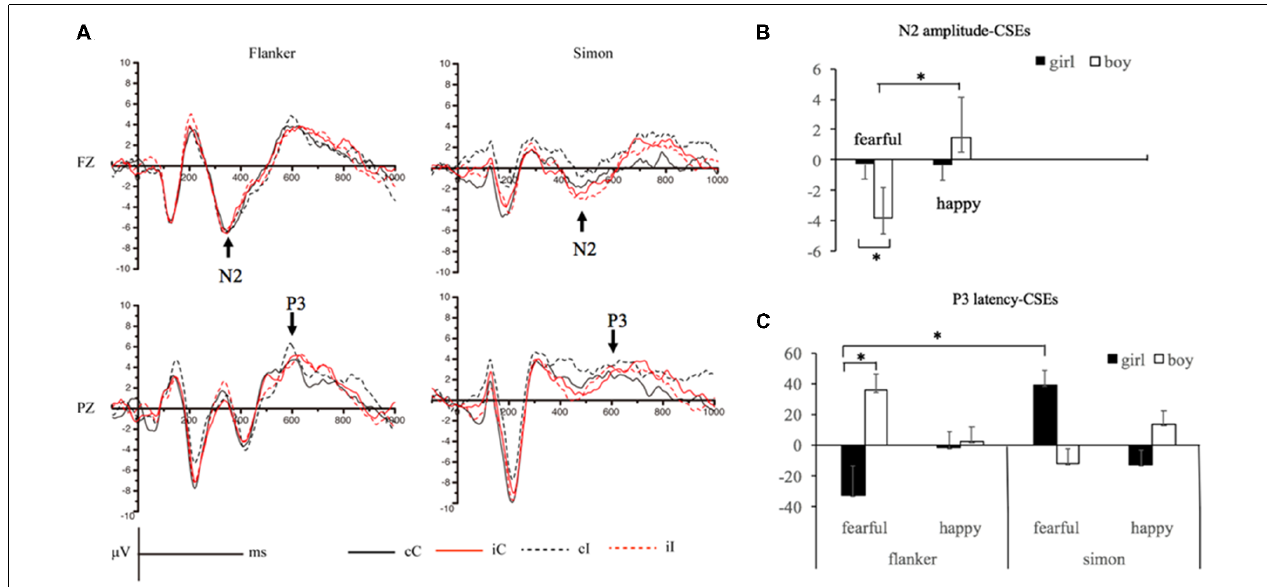
FIGURE 2 | Panel (A) shows the averaged N2 and P3 waveforms in the Flanker and Simon tasks, respectively. Panel (B) Presents the congruency sequence effects (CSEs) of N2 amplitude. Panel (C) shows the CSEs of P3 latency. Note : cC, congruent trial preceded by a congruent trial; cI, incongruent trial preceded by a congruent trial; iC, congruent trial preceded by an incongruent trial; iI, incongruent trial preceded by an incongruent trial. ∗ indicates p < 0.05.